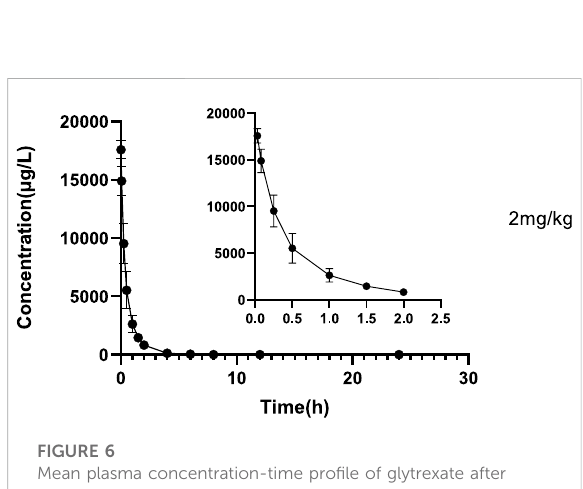
FIGURE 6 Mean plasma concentration-time pro fi le of glytrexate after 2 mg/kg glytrexate was injected into the tail vein of rats ( n =